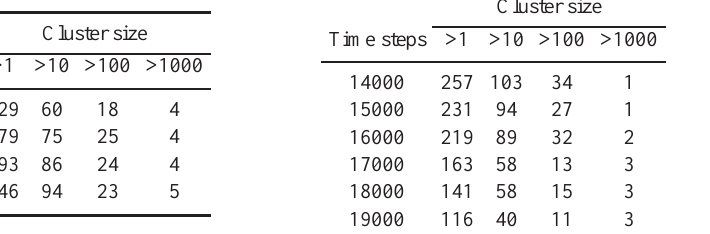
Table 1. Dependence of cluster distribution on the weight of